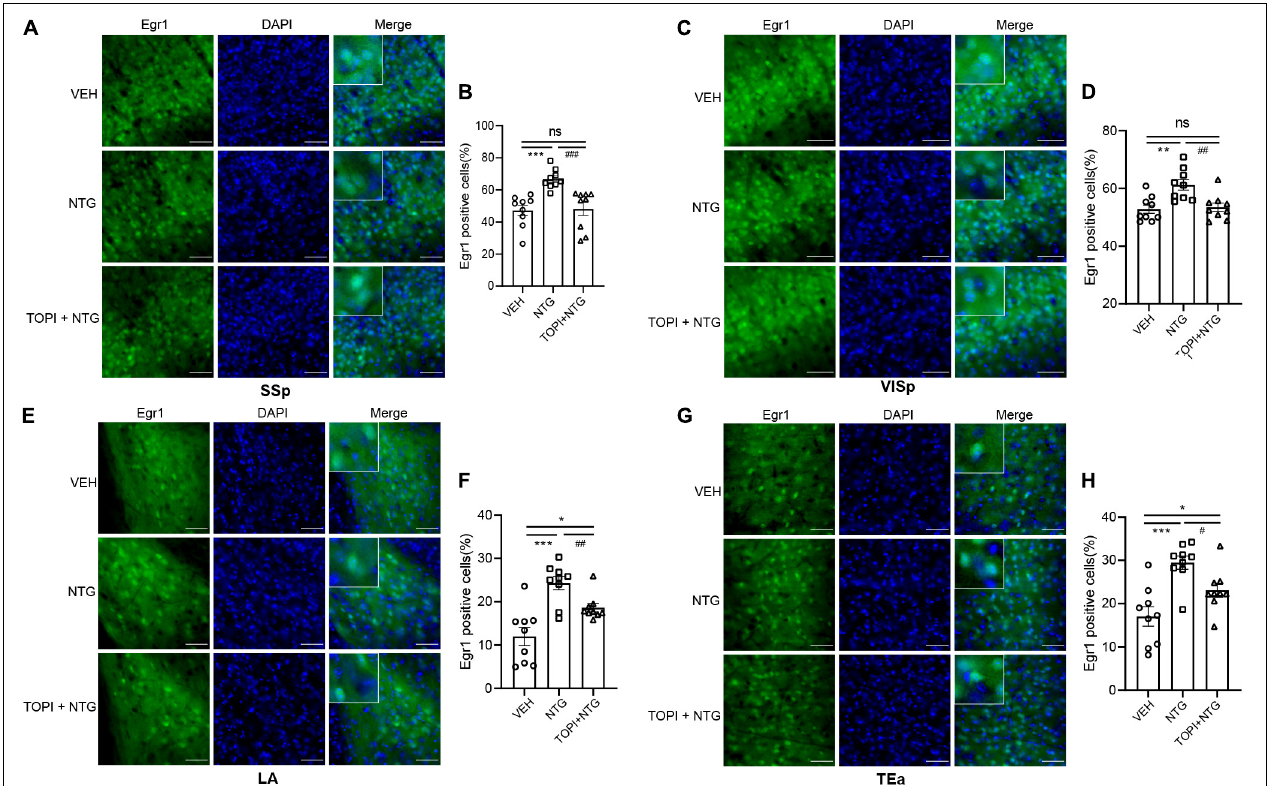
FIGURE 6 | Egr1 expression in SSp, VISp, LA, and TEa of CM model after topiramate treatment. The increased Egr1 expression induced by NTG was decreased to varying degrees by topiramate in these regions. (A–F) There was no statistical difference between the control group and topiramate + NTG group in the SSp and VISp. (G,H) The numbers of Egr1 positive cells in the topiramate + NTG group were still higher in LA and TEa than that in the control group. Student’s t test. n = 3/group. * p < 0.05, ** p < 0.01 compared with vehicle. # p < 0.05, ## p < 0.01, ### p < 0.001 compared with NTG. Scale bars = 50 µ m. Egr1, early growth response protein 1; SSp, primary somatosensory cortex; VISp, primary visual area; LA, lateral amygdala nucleus; TEa, temporal association